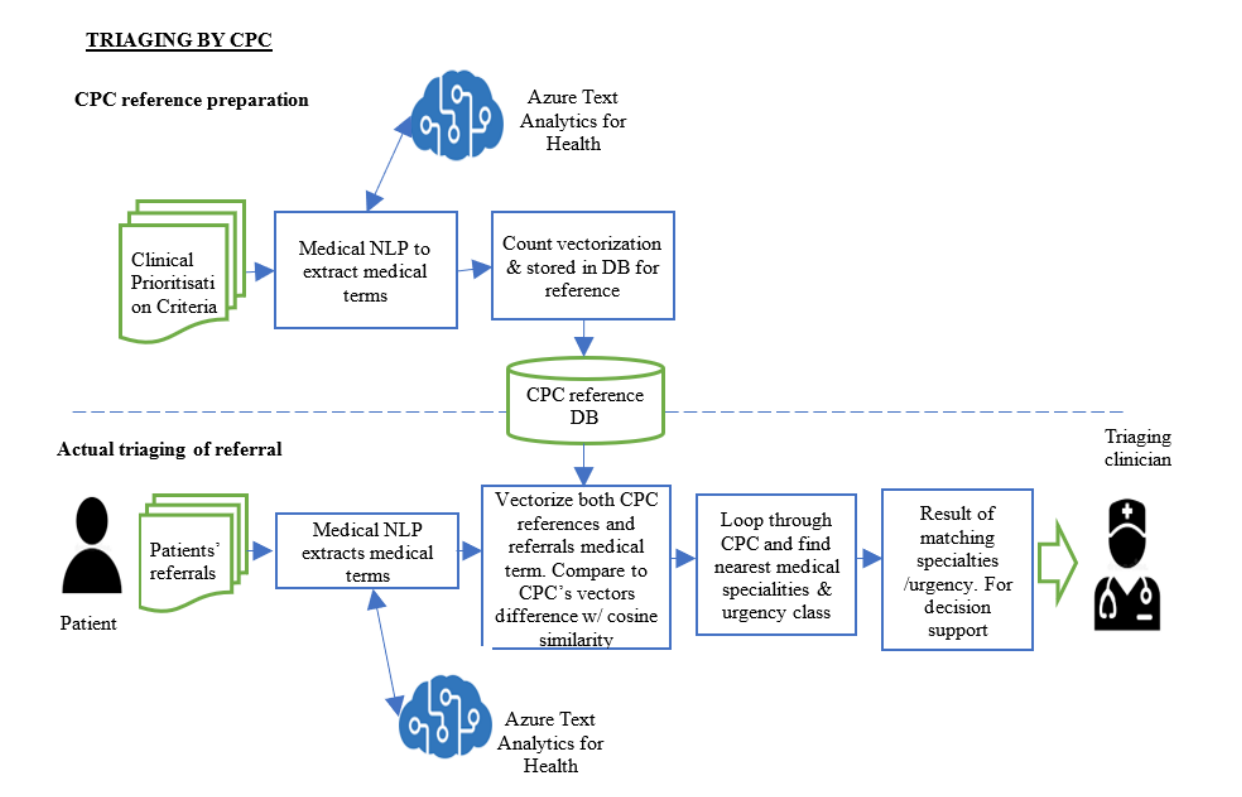
Figure 1. The architecture of a proposed CPC-based referral triaging system.